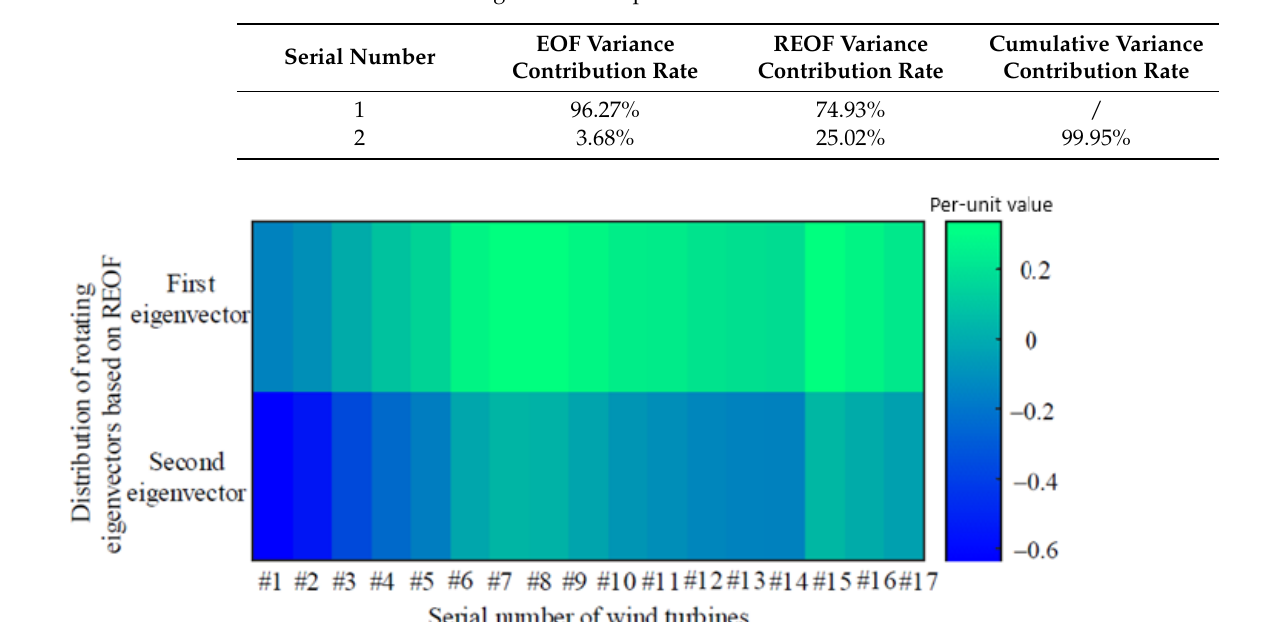
Table 1. The Variance Contribution rate and Cumulative Variance Contribution Rate of the First Two Feature Vectors of Regional Wind Speed Based on EOF and REOF.